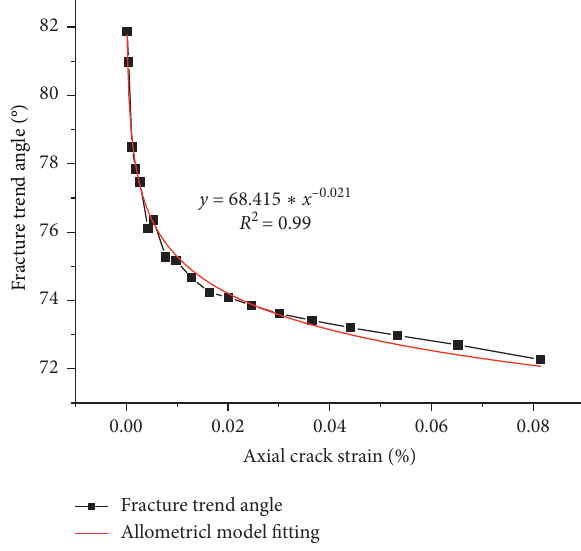
y = 68.415 ∗ x –0.021 R 2 = 0.99